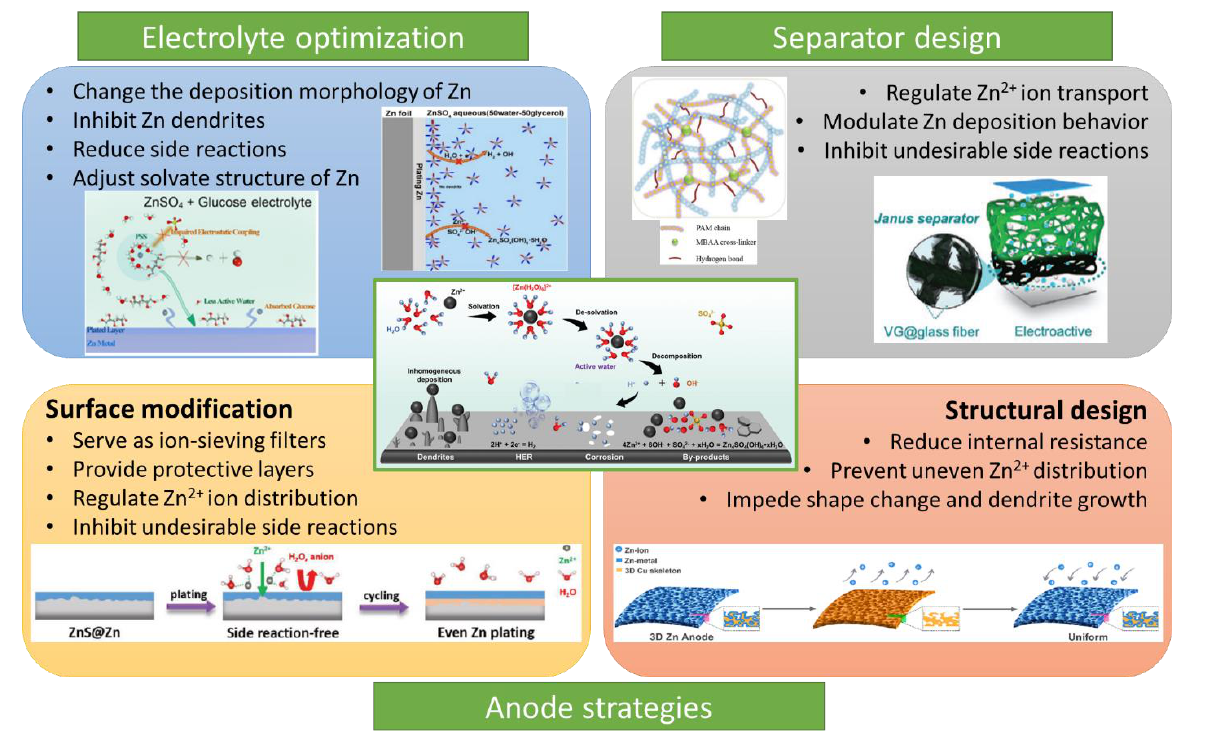
Figure 2. Schematic diagram of issues and strategies related to Zn anodes (Reproduced with per-